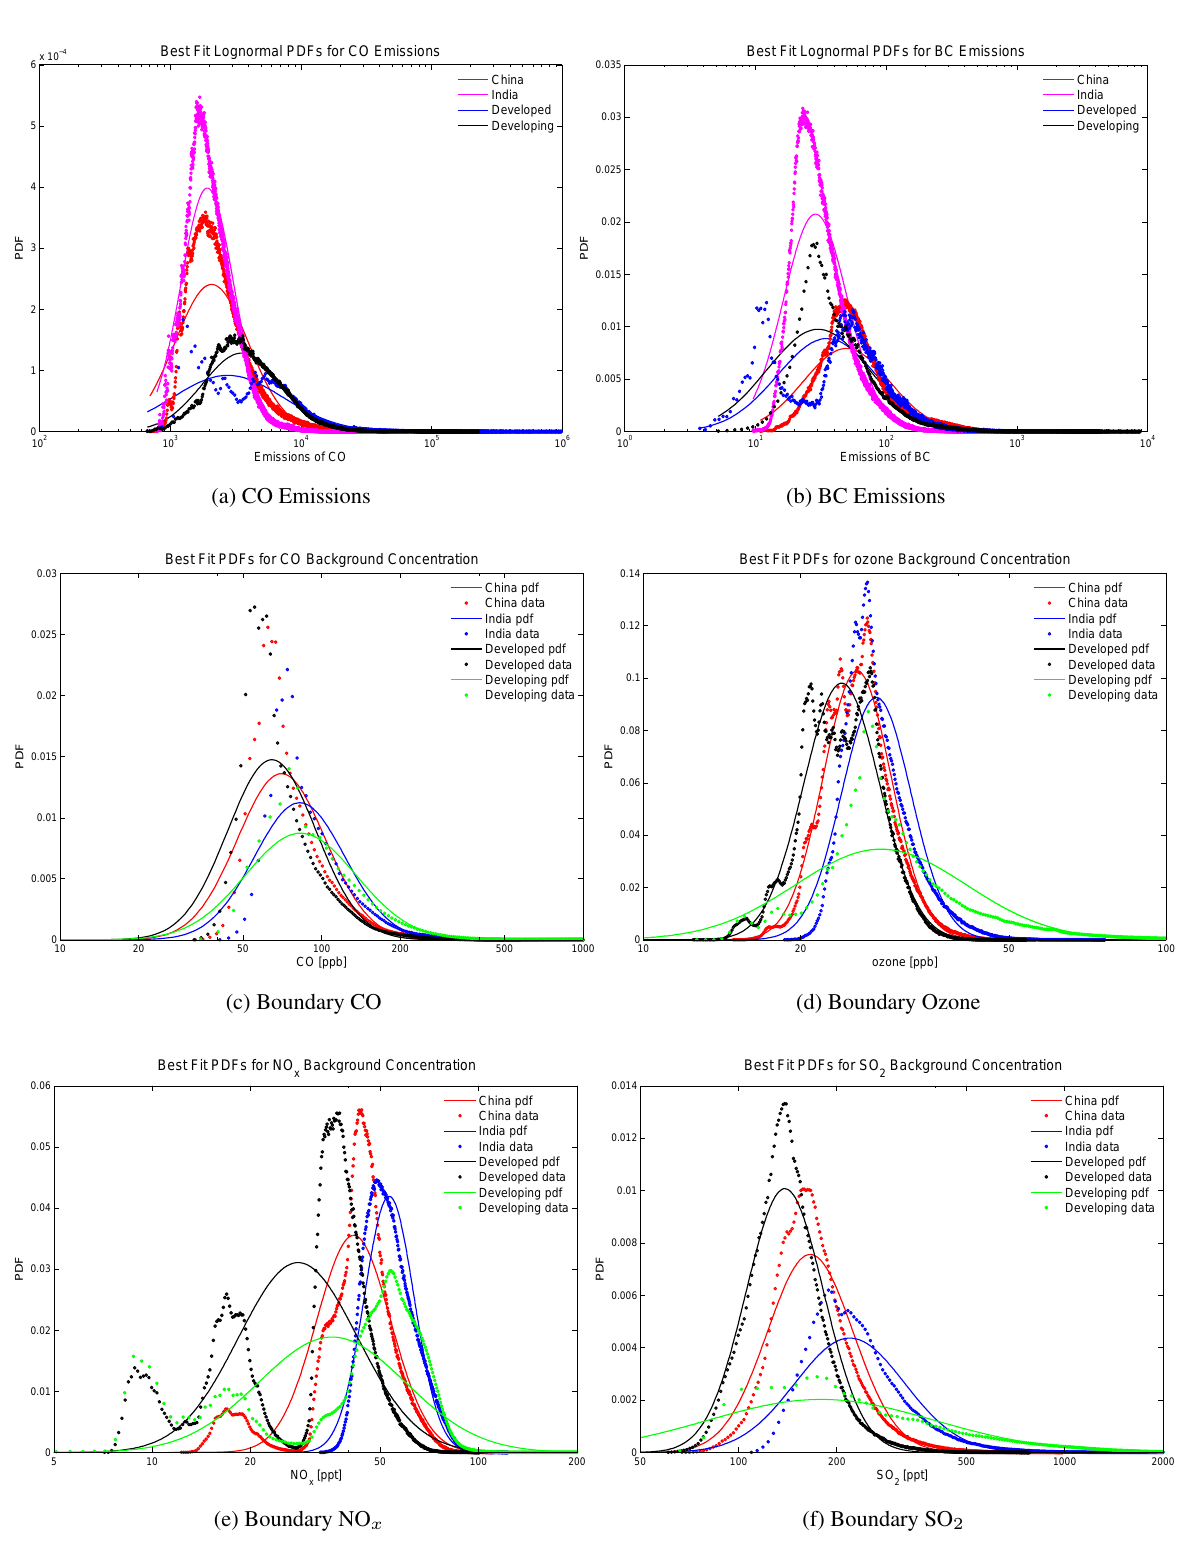
Fig. 1. PDFs of CO and BC emissions tonday − 1 , and the boundary mole fractions of CO, ozone, NO x , and SO 2 , for each metamodel type. The dots represent the aggregated, binned, and normalized data points, while the lines represent the best fit lognormal PDFs of the respective data sets. The coefficients for these best fit lognormal PDFs are given in Table 2.